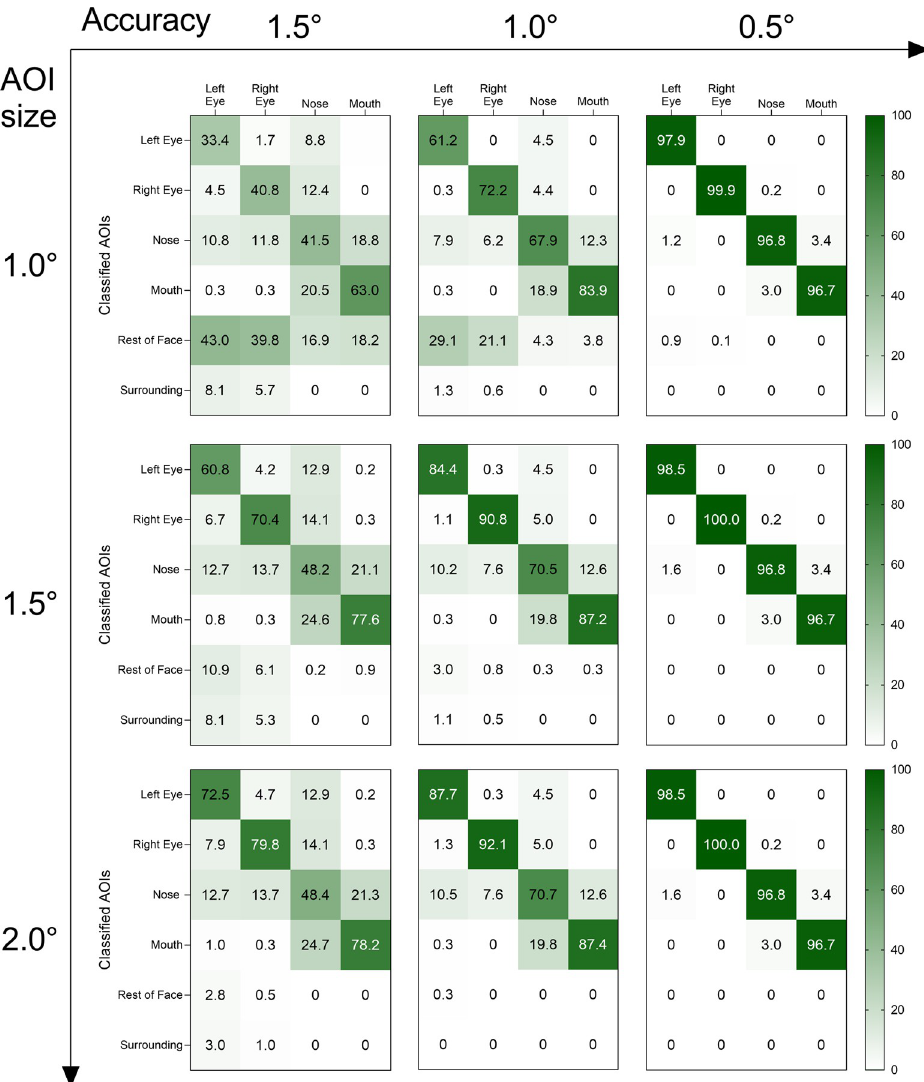
Fig 2. Confusion matrices of the fixation classification performance as a function of gaze data accuracy and AOI size. The percentages in the diagonal represent correctly classified fixation points, while the percentages outside the diagonal represent misclassified fixation points. The percentages in the last two rows correspond to the number of unclassified fixation points (rest of face & surrounding). forehead. The mean distance between the forehead target point and AOI center points of the eyes was approx. 1.56˚. Fig 3D shows that large AOIs in combination with good gaze data qual- ity (0.5˚ accuracy) result in almost all fixation points being misclassified (inflation of Type I error). As expected, most fixation points were falsely classified as belonging to the left or right eye. Smaller AOIs in combination with good data quality, on the other hand, lower numbers of false-positives drastically with over 90% of fixation points being correctly classified outside any specific AOI. The effect of accuracy is inverse, while smaller AOIs profit from better accu- racy in terms of Type I errors, whereas the error increases slightly with better accuracy for larger AOIs.